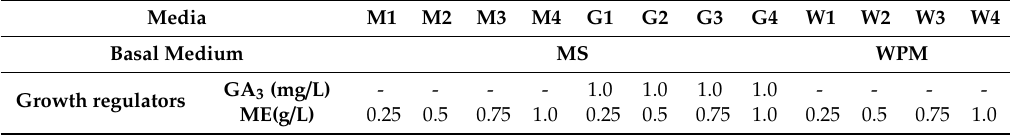
Table 1. Media combinations used for the initial establishment of embryo